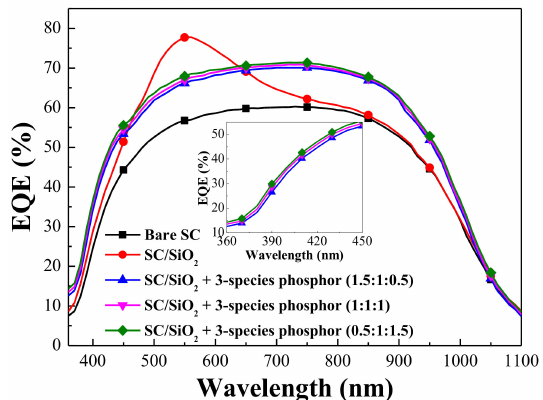
Figure 6. External quantum efficiency (EQE) response of bare silicon solar cell, cell coated with a 250-nm thick layer of SiO 2 , and cells coated with a SiO 2 layer that included three species of Eu-doped phosphors at various weight ratios (0.5:1:1.5, or 1:1:1, or 1.5:1:0.5 in wt %).